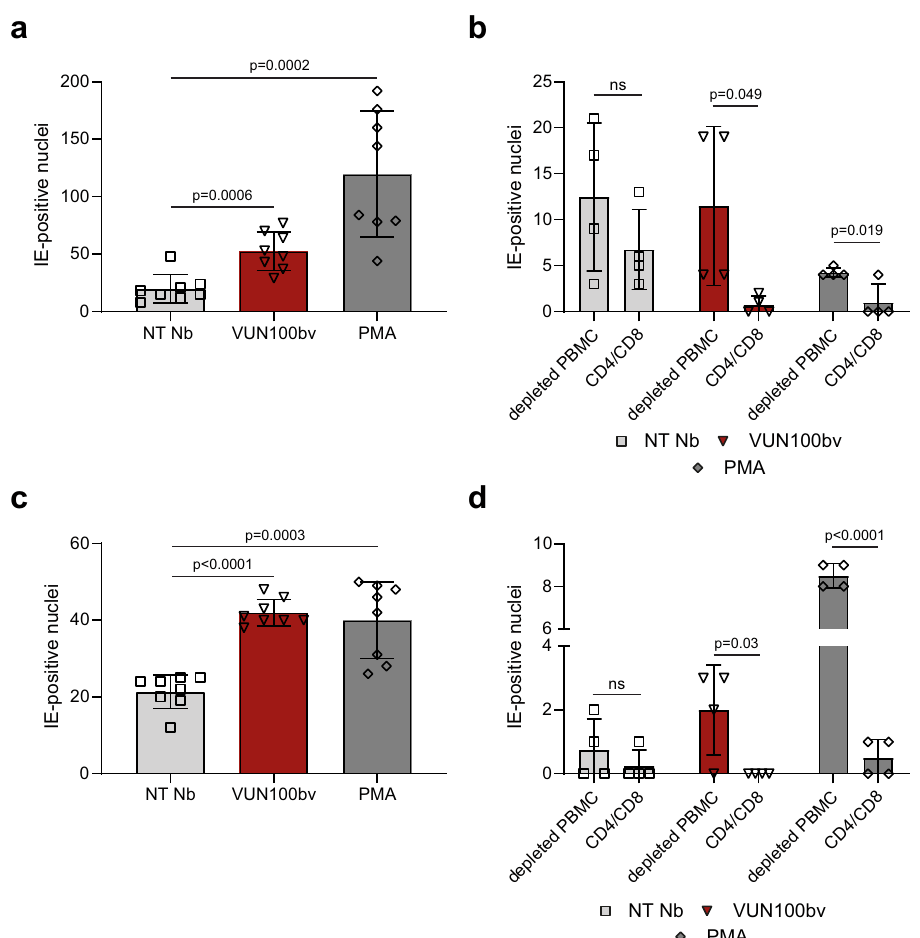
Fig. 4 HCMV-infected CD14 + monocytes are targets for HCMV-speci fi c T cells upon VUN100bv treatment. a Counting of IE-positive CD14 + monocytes before co-culture with CD4/CD8 + T cells or T-cell-depleted PBMCs. CD14 + monocytes were treated with a non-targeting nanobody (NT Nb), VUN100bv for 6 days post infection or pre-treated with 20ng/ml PMA before infection. b Counting of IE-positive CD14 + monocytes after co-culture of T-cell-depleted PBMCs (depleted PBMC) or T cells (CD4/CD8) and differentiation of CD14 + monocytes to mature dendritic cells. c Counting of IE-positive CD14 + monocytes before co-culture with CD4/CD8 + T cells or T-cell-depleted PBMCs. Six days post infection, CD14 + monocytes were treated with NT Nb, VUN100bv, or 20ng/ml PMA for 1 day. d Counting of IE-positive CD14 + monocytes after co-culture of T-cell-depleted PBMCs (depleted PBMC) or T cells (CD4/CD8) and differentiation of CD14 + monocytes to mature dendritic cells. Representative fi gures, showing technical replicates, from two biological replicates are shown. All data are plotted as mean ± S.D. For all fi gures, statistical analyses were performed using unpaired two-tailed t test. ns, p > 0.05. Source data are provided as a Source Data fi